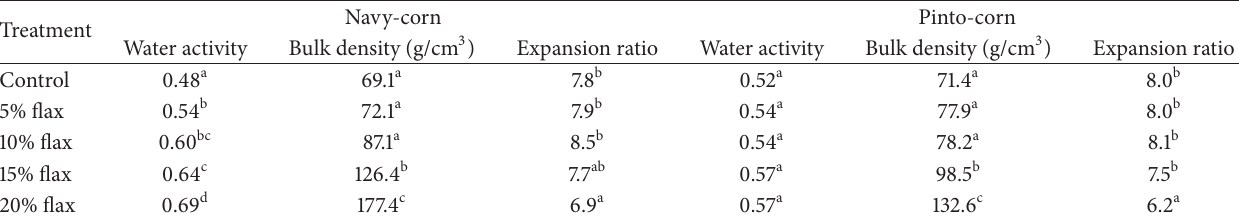
Means in column with the same letter are not significantly ( 𝑃 > 0.05 ) different.